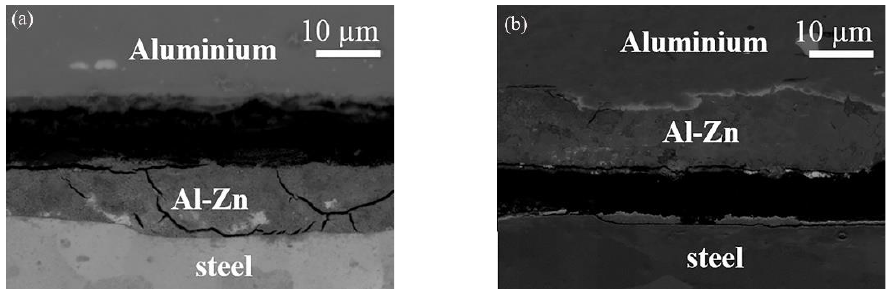
Figure 24. Fracture path between Aluminum alloy and galvanized steel with an increase in the welding time [32]: ( a ) 0.5 s; ( b ) 3.0 s.